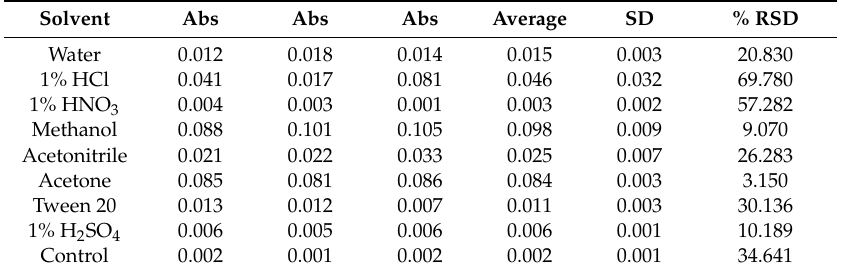
Table 2. A comparison between absorbance values of quartz cuvettes rinsed with di ff erent